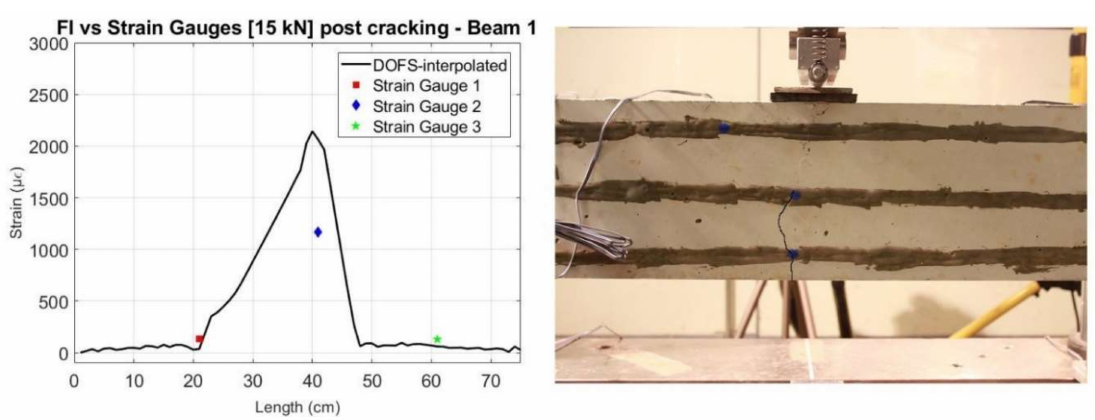
Figure 22. Comparison of interpolated values of DOFS with Strain Gauges for a 15 kN load ( left ) and photo of beam specimen with highlighted crack ( right )—Beam 1.